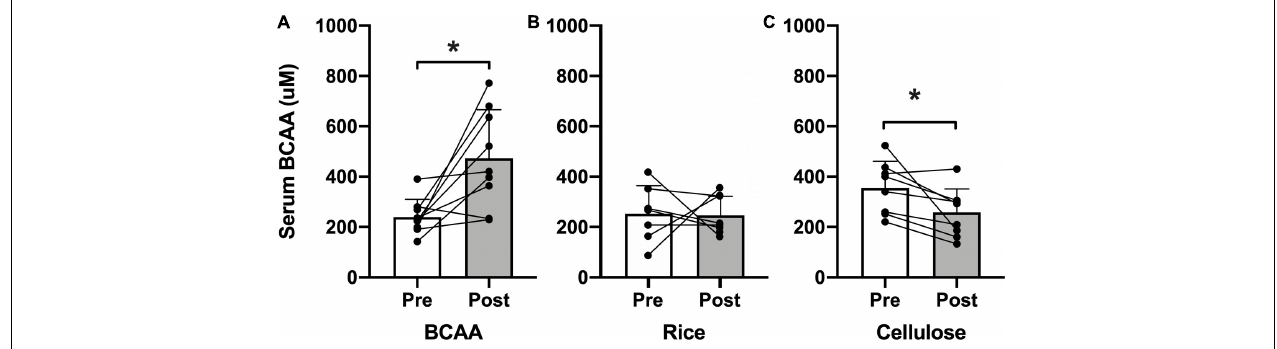
FIGURE 2 | Serum BCAA concentration. Pre- (open bars) and post-intervention (shaded bars) serum BCAA concentration ( µ M) for the (A) BCAA, (B) rice protein, and (C) microcrystalline cellulose groups (mean ± standard deviation). Individual data points with connecting lines overlaid. * p < 0.05, paired two-tail t -test.